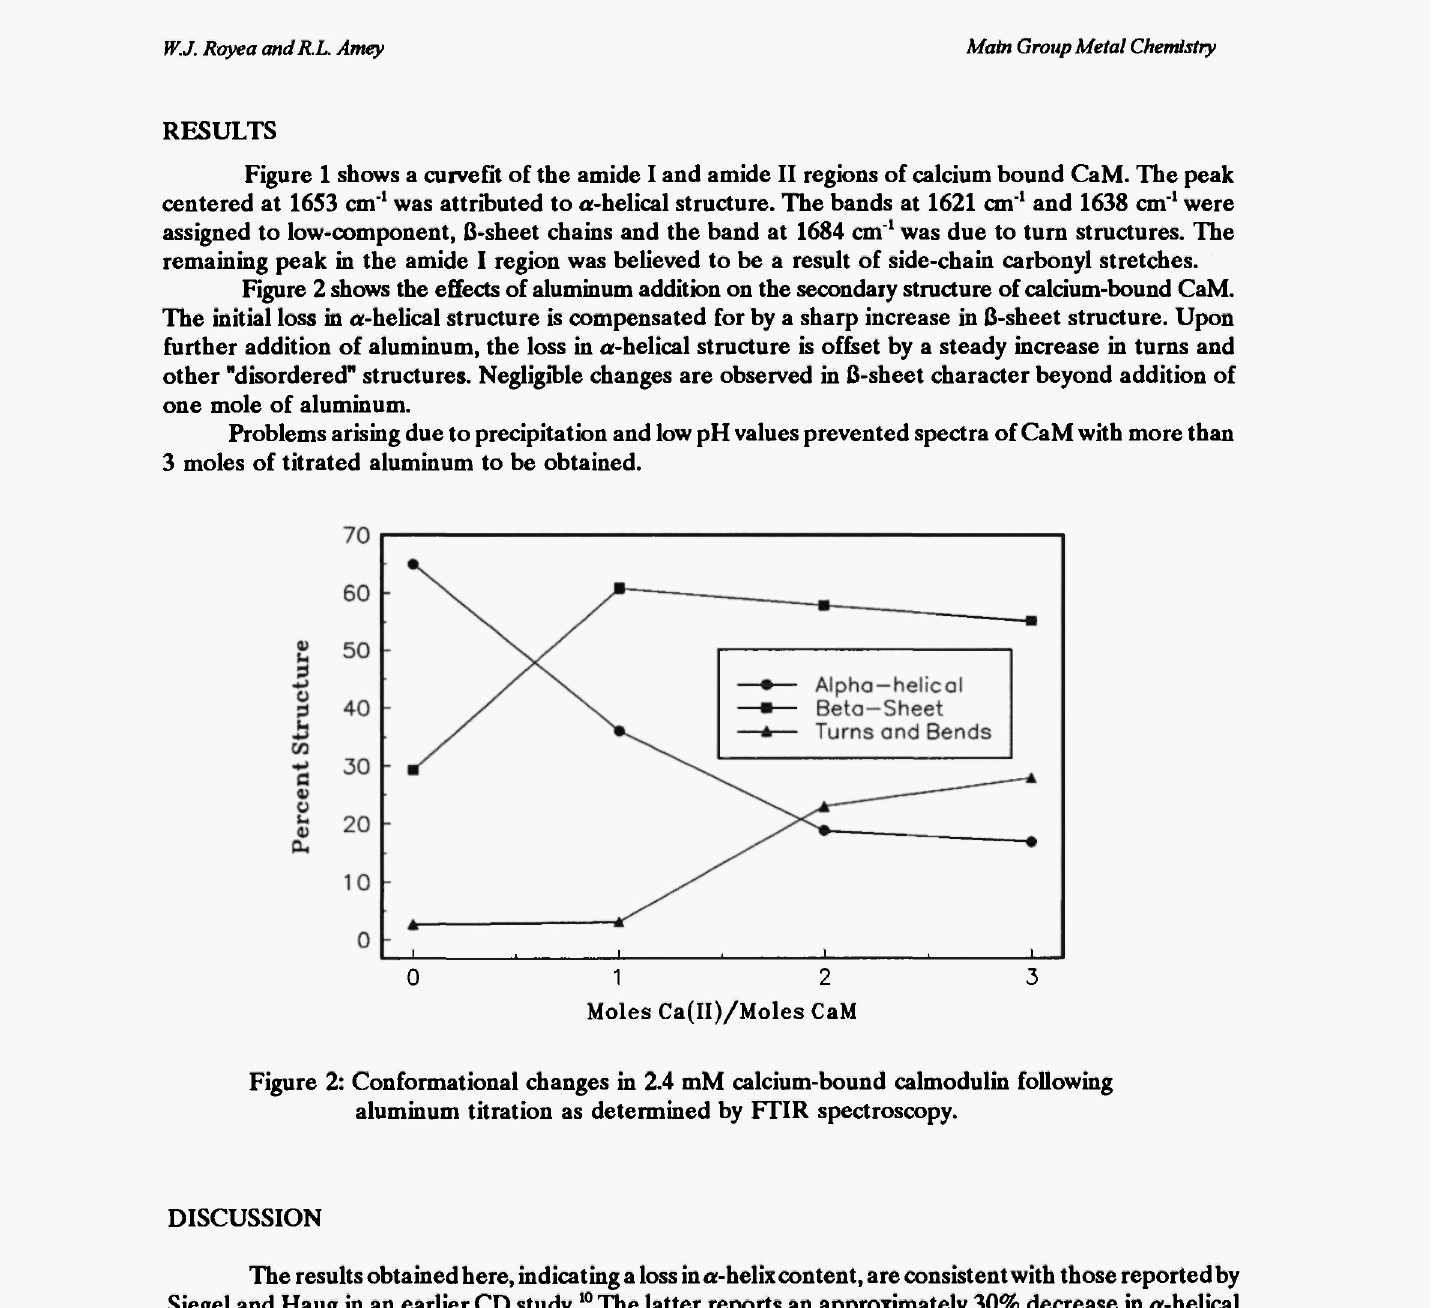
Figure 2: Conformational changes in 2.4 mM calcium-bound calmodulin following aluminum titration as determined by FTIR